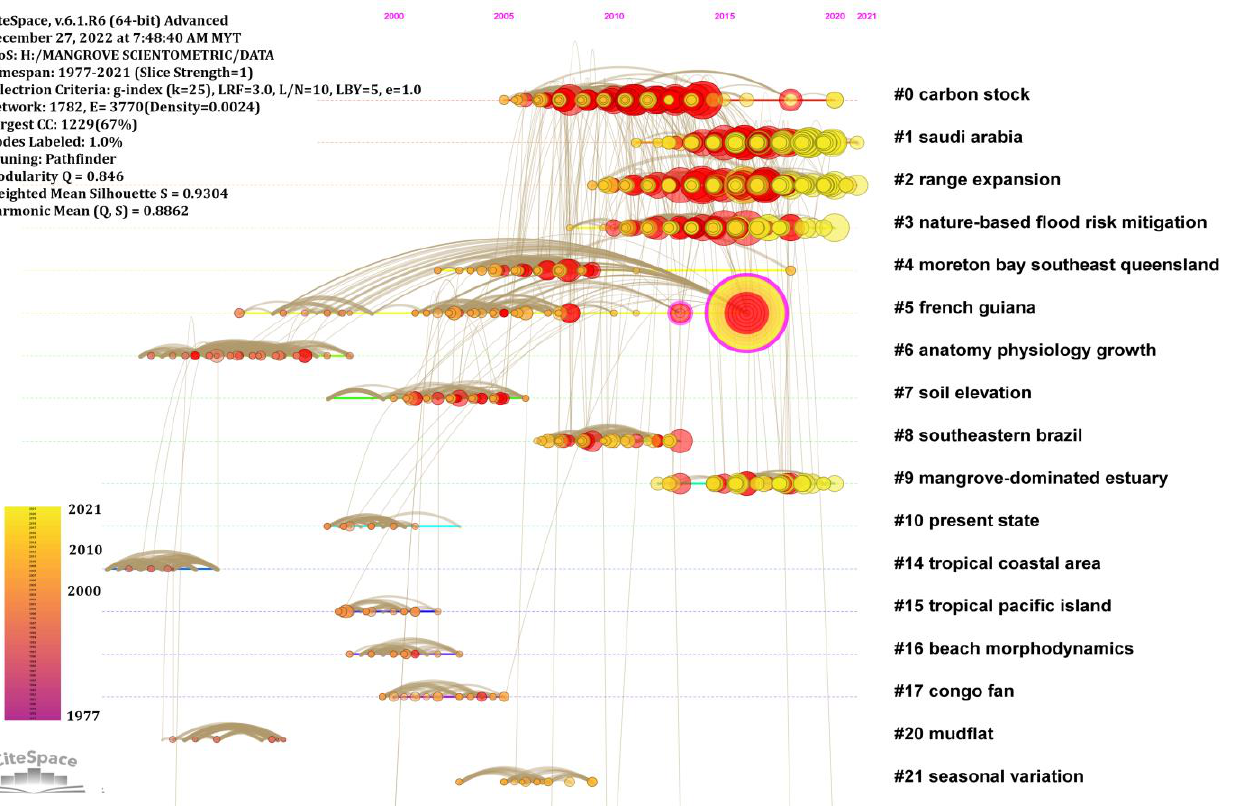
Figure 7 . Timeline co-citation cluster analysis. Nodes represent reference names, whereas lines represent connections between those references. The size of the nodes in the network reflects the frequency of citation, while the colors of the nodes, ranging from magenta (1977) to yellow (2021), indicate the progression of research over time. References with strong citation bursts are shown with red nodes.